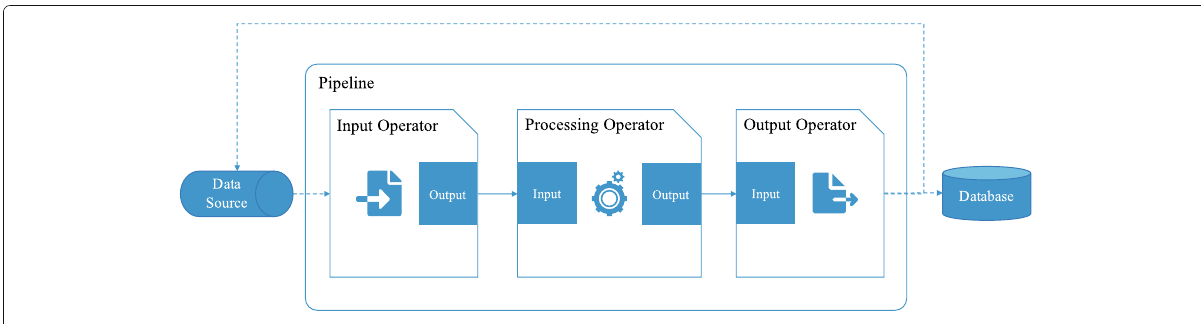
Fig. 3 Generalized pipeline in AIoT